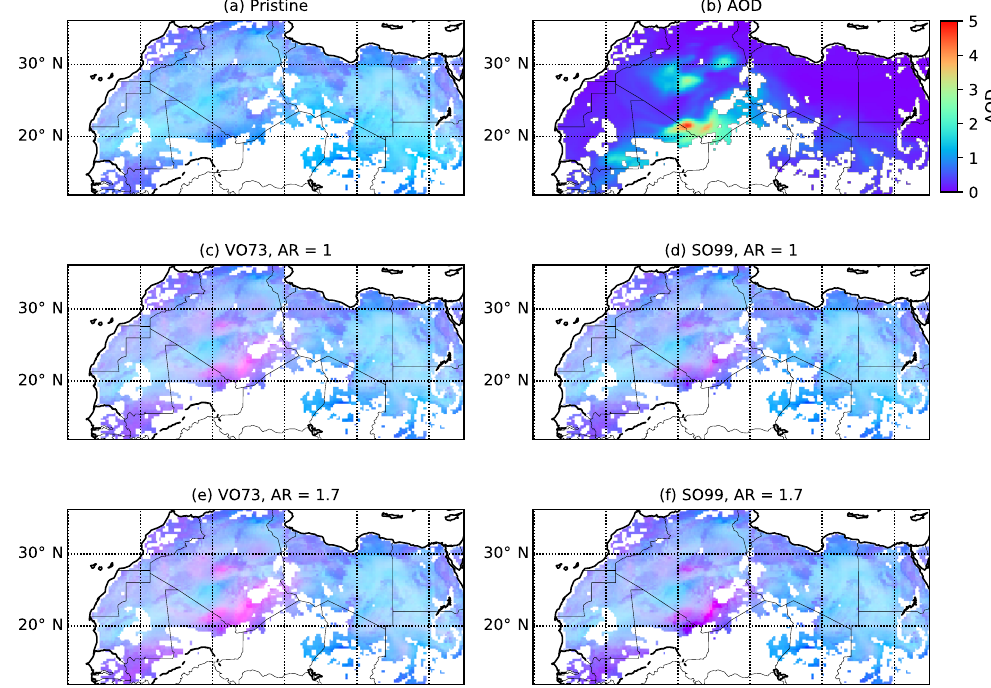
Figure 9. Simulated SEVIRI Desert Dust RGB images, 12:00UTC on 25 June 2013. (a) Pristine-sky; (b) COSMO-MUSCAT AOD at 550nm; (c, e) VO73 dust for AR values of 1 and 1.7 (horizontally aligned); (d, f) the SO99 dust mixture for the two AR